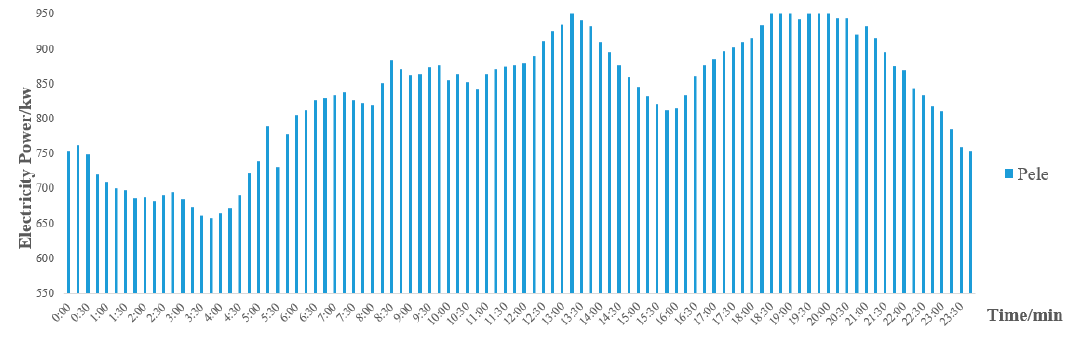
Figure 4. Summer electricity power load chart.